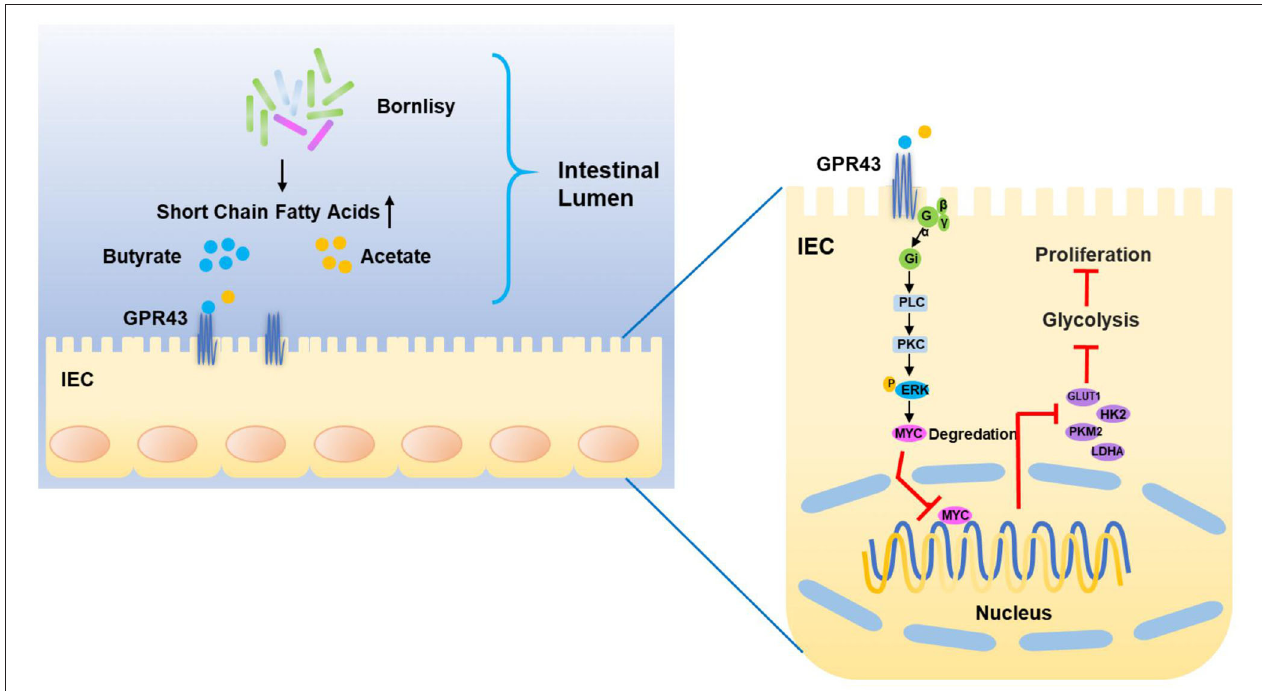
FIGURE 8 | Proposed model of the mechanism underlying the BO-induced suppression of CAC via inhibiting the GPR43-mediated glycolysis.